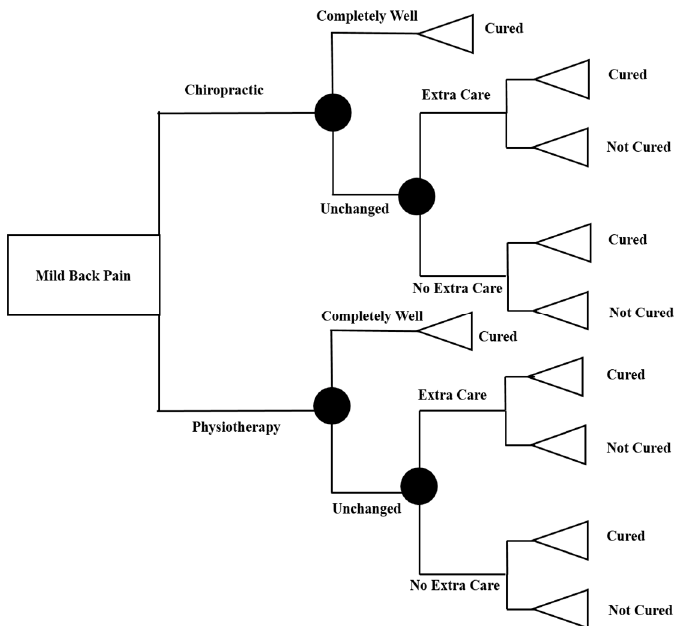
Figure 1. Decision tree.